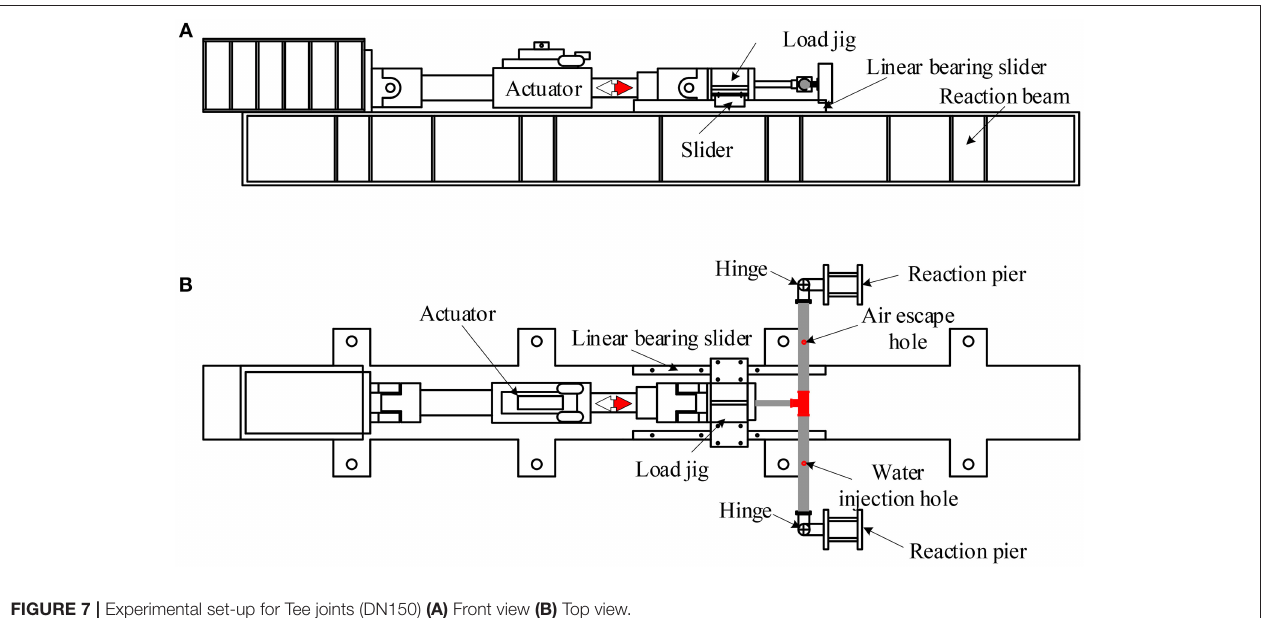
FIGURE 7 | Experimental set-up for Tee joints (DN150) (A) Front view (B) Top view.